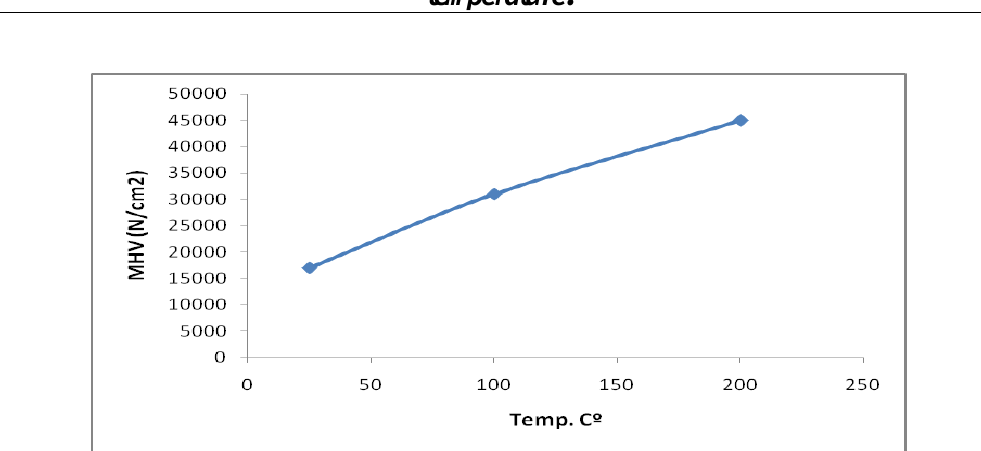
Fig. 6: Transmittance spectrum of Se thin film un annealed and annealing different temperature.